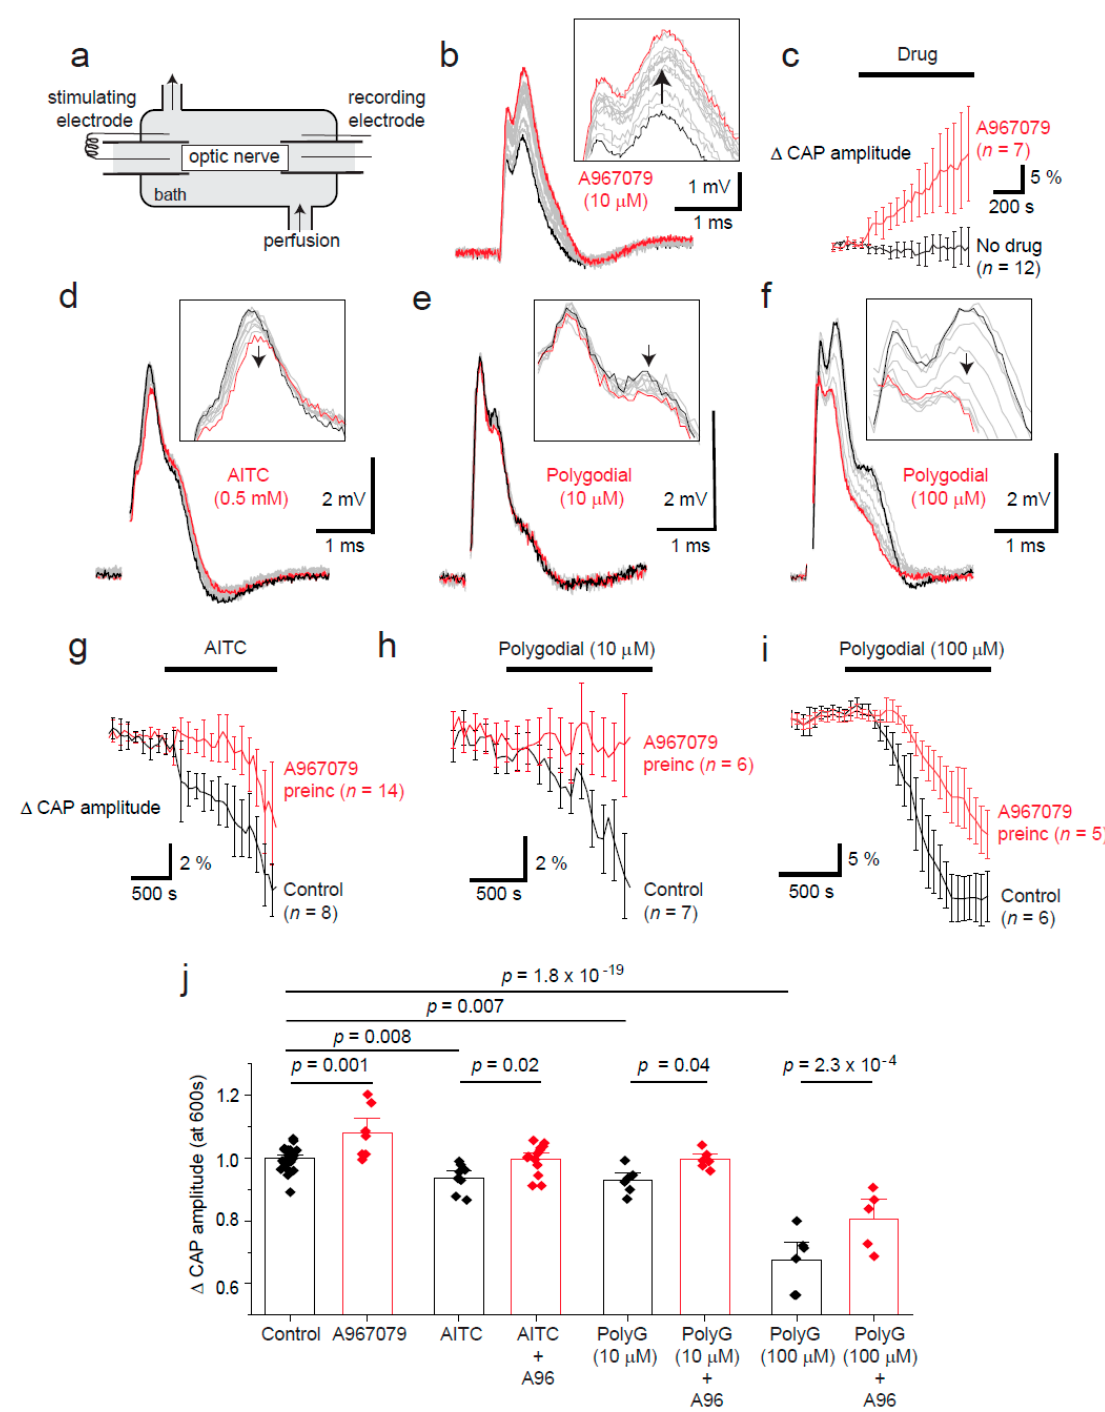
Figure 2. TRPA1 agonist and antagonist effects on optic nerve compound action potential amplitude. ( a ) Compound action potentials (CAPs) were measured in young adult optic nerves (P42–P70). ( b ) A-967079 (A96, 10 µ M) block of TRPA1 increases the CAP amplitude (black trace at start; with time this increases (grey traces), and the red trace is the final trace). The arrows indicate the direction of change in CAP measurements with time. ( c ) Mean ( ± SEM) CAP amplitude increases after application of A-967079 (10 µ M; n = 7) compared to vehicle (DMSO; n = 12), and decreases after TRPA1 agonist application: AITC (500 µ M, ( d , g , j ), n =8); and polygodial (10 µ M, ( e , h , j ), n = 7; and 100 µ M, ( f , i , j ), n = 6). TRPA1–evoked decreases can be significantly inhibited by over 15 min of preincubation with A-967079 (20 µ M, g – j ). ( j ) Bar graph showing the mean ( ± SEM) changes in CAP amplitude (each n is depicted as a diamond data point) after application of agonists and antagonists for 10 min. p -values are from multiple comparisons using a one-way ANOVA with Holm–Bonferroni